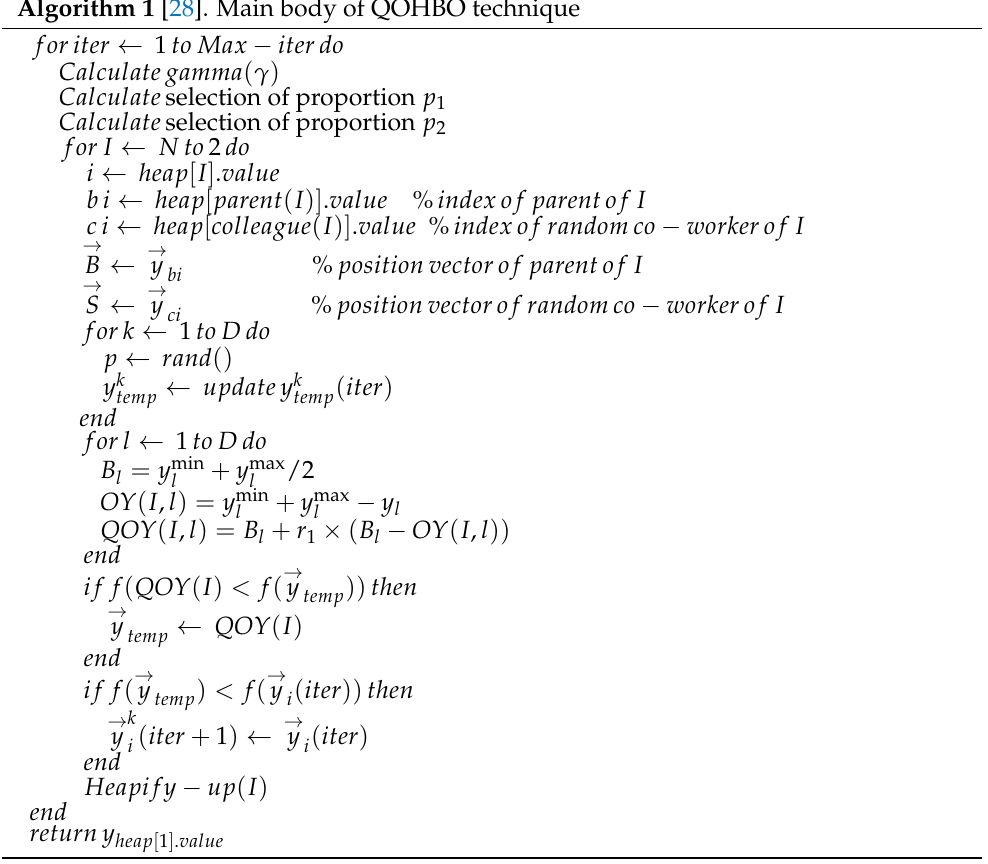
Algorithm 1 [28]. Main body of QOHBO